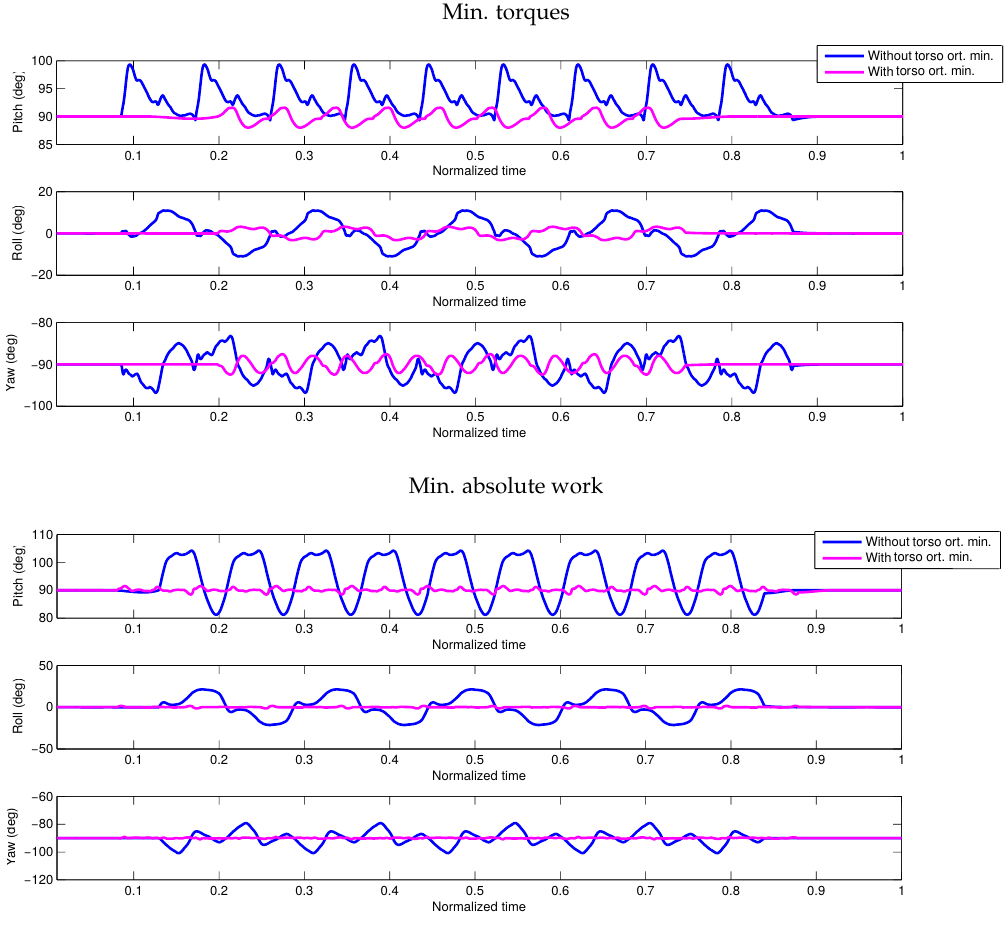
Figure 9. Torso orientation trajectories for the two cases of minimization of torques and absolute work. The orientation is expressed with respect to the world reference frame. The nominal reference (torso upright) is [90, 0, − 90]. Time is normalized for all trajectories for comparison